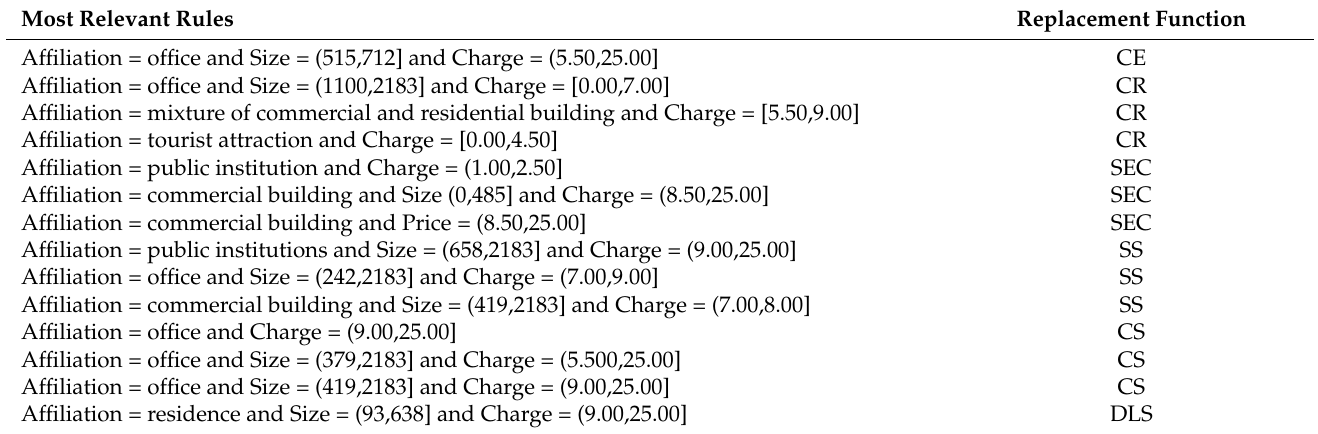
Table 8. Most relevant rules for the replacement